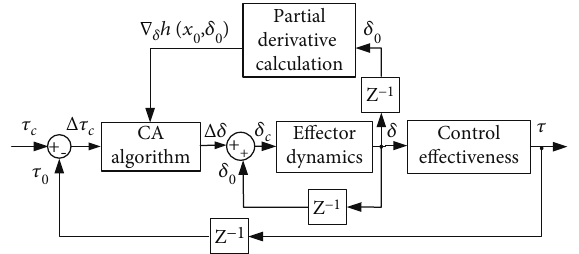
Figure 4: Flow chart of incremental nonlinear control allocation